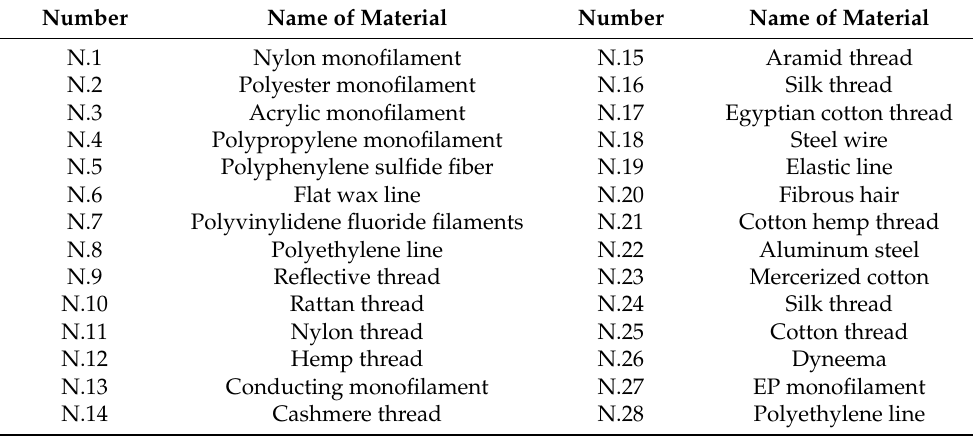
Table 1. Linear materials used in the